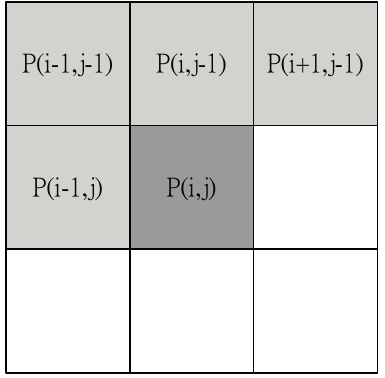
Figure 16 . The mask for the initial seed.